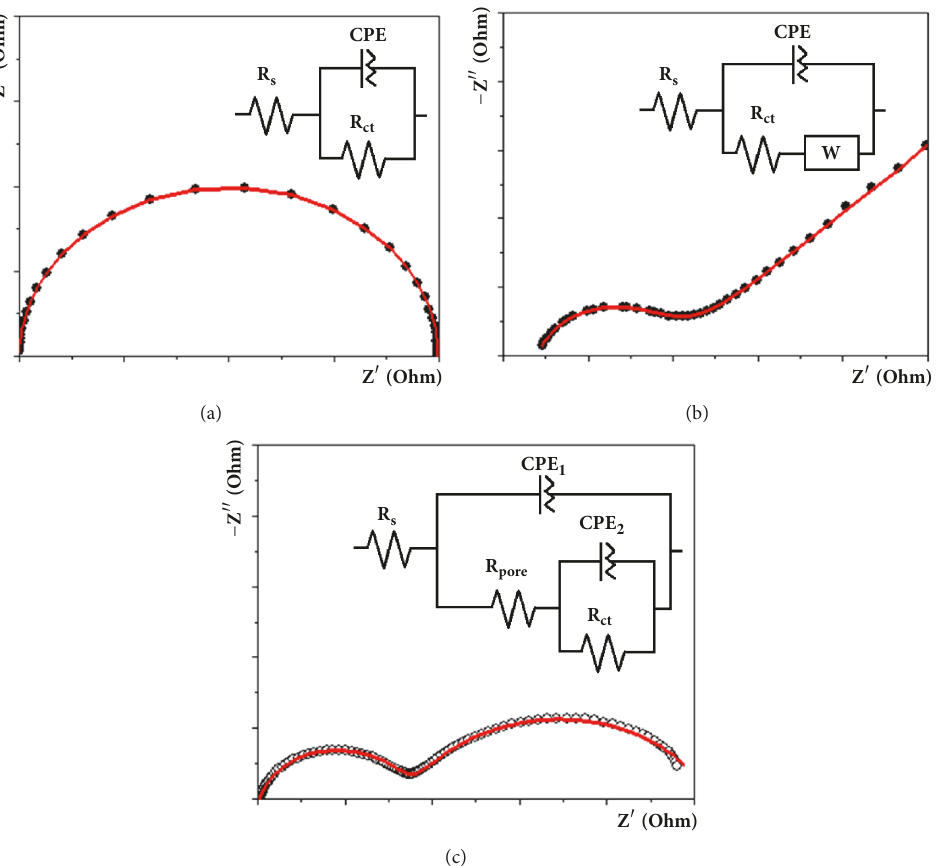
Figure 8: Nyquist plots for impedance data and equivalent circuits used to fill each curve for a metal or alloy (a) without any coating, (b) without a coating showing diffusion of reactants, and (c) with a passive oxide layer or a porous coating on the